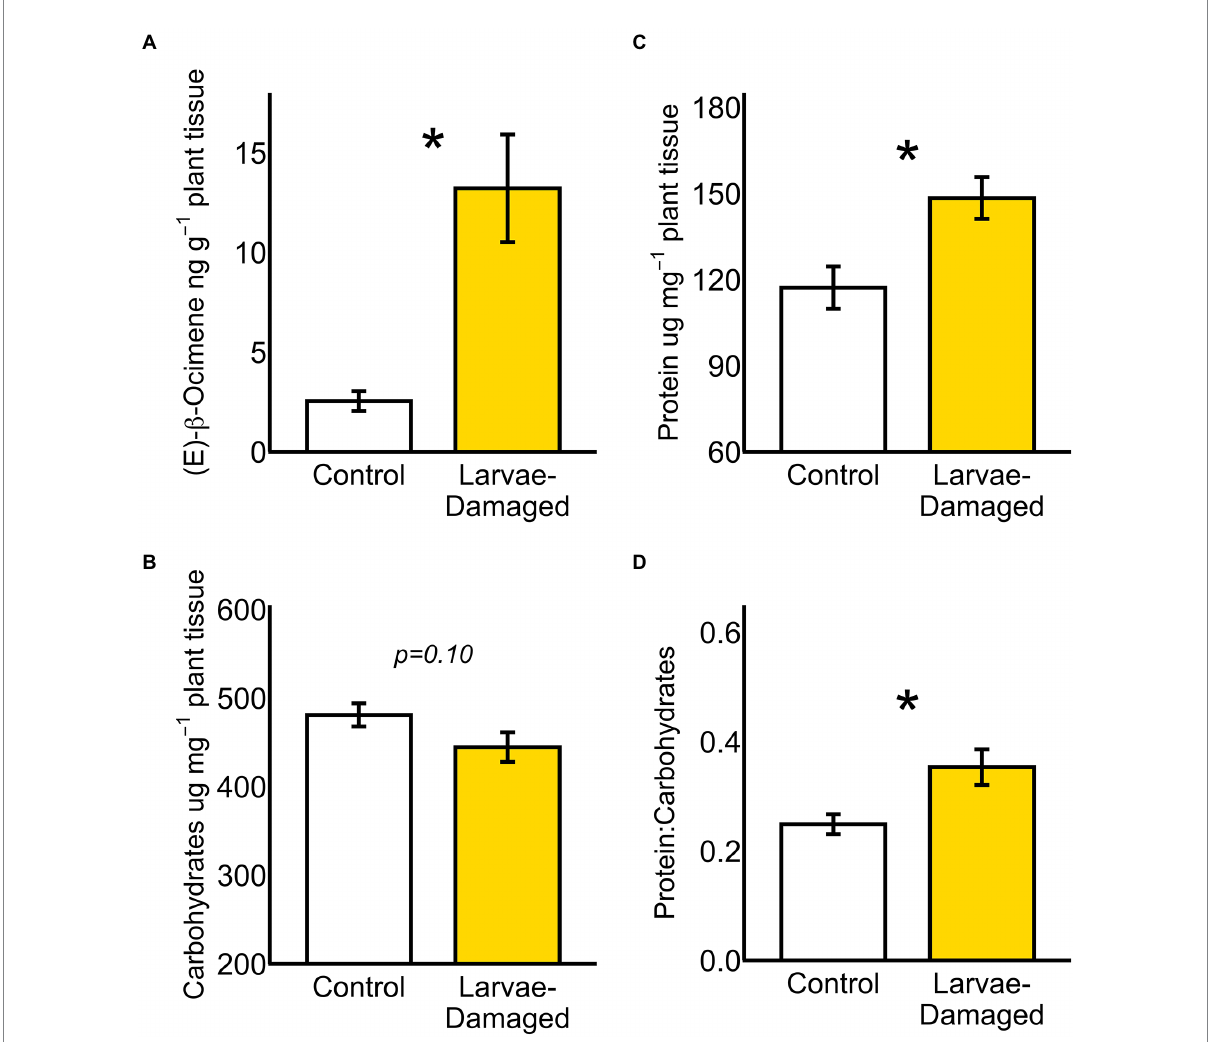
FIGURE 3 (A) Belowground larval herbivory induced systemic increases in aboveground ( E )- β -ocimene emission, but did not significantly modify aboveground (B) carbohydrates. Belowground larval herbivory enhanced aboveground leaf (C) protein content and (D) the ratio of protein: carbohydrates. (* p ≤ 0.05) Means ± SE are